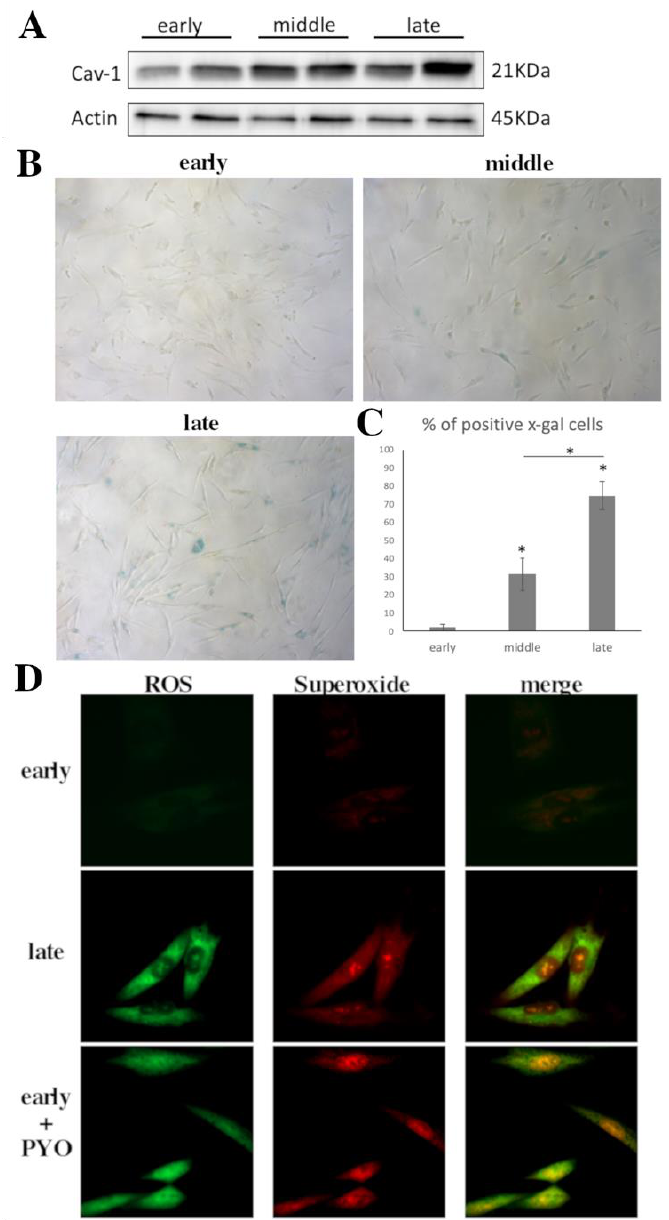
Figure 1. Cav-1 levels increase as cells reach senescence. ( A ) Characteristic Immunoblot showing caveolin-1 (Cav-1) levels increasing significantly as WJ-MSCs reach senescence. β -Actin was used as control for equal protein loading. ( B ) Representative photos of early-, middle- and late-passage cells stained with SA- β -gal staining solution. ( C ) Graph showing the percentage of SA- β -gal positive cells in early-, middle- and late-passage cells as mean from three donors. * p < 0.05 vs. NT or otherwise indicated. p values calculated using the Student t -test. ( D ) Representative images of early- and late- passage WJ-MSCs where total ROS and superoxide levels were analyzed under normal conditions (early–late). For a positive control pyocyanine was added to the early passage cells (early + PYO). Images were captured with the 40X objective lens of the fluorescent microscope used.